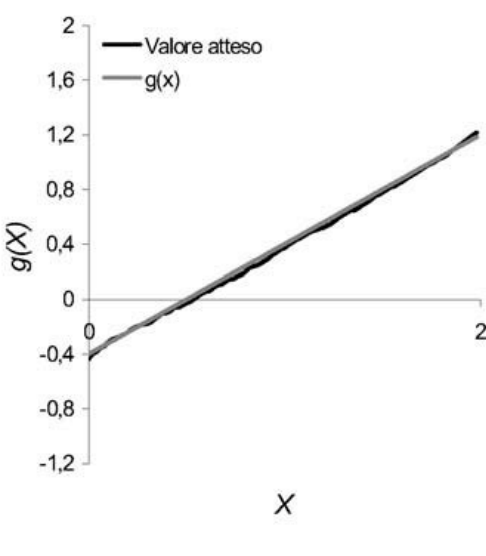
Figura 1 – Modello I: valore atteso del supersmoother.